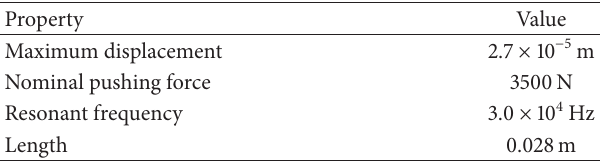
Table 4: Piezoelectric actuator properties